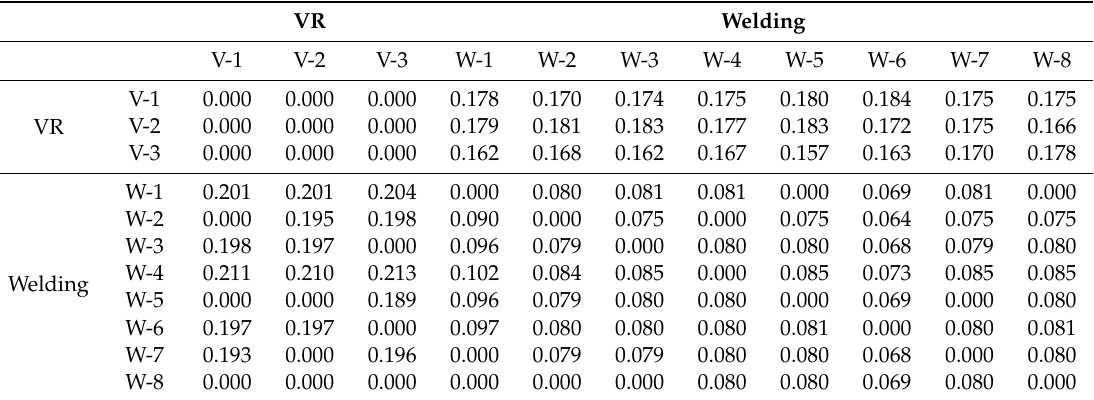
Table A2. The unweighted supermatrix of the importance.